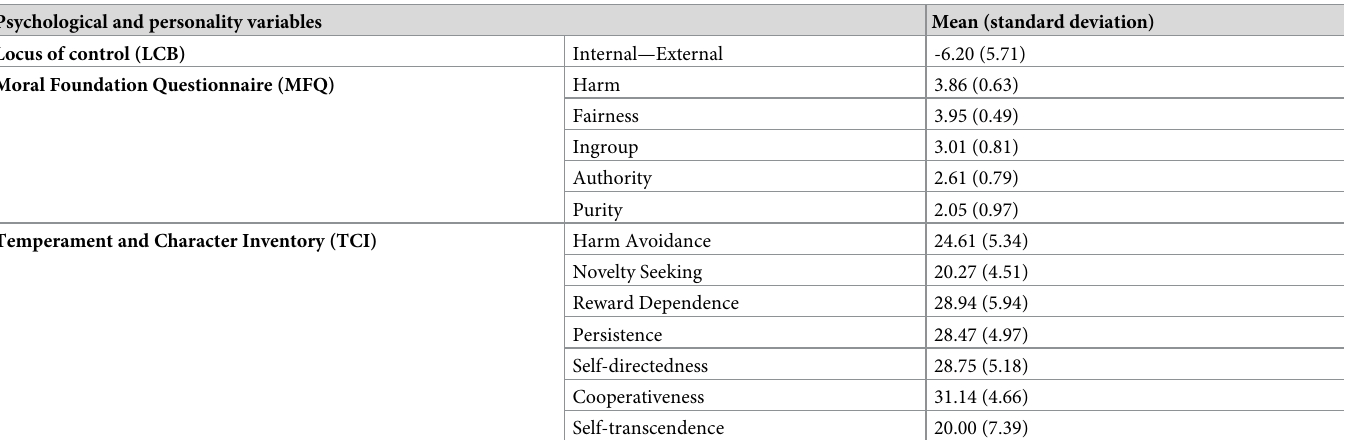
Table 2. Descriptive statistic for psychological and personality variables.